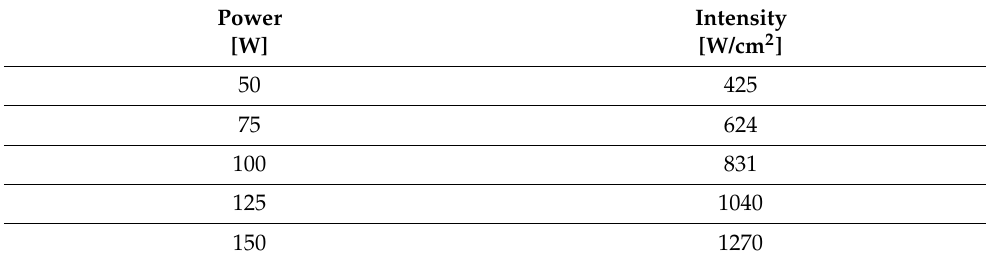
Table 1. Acoustic power and corresponding intensity at the focus.